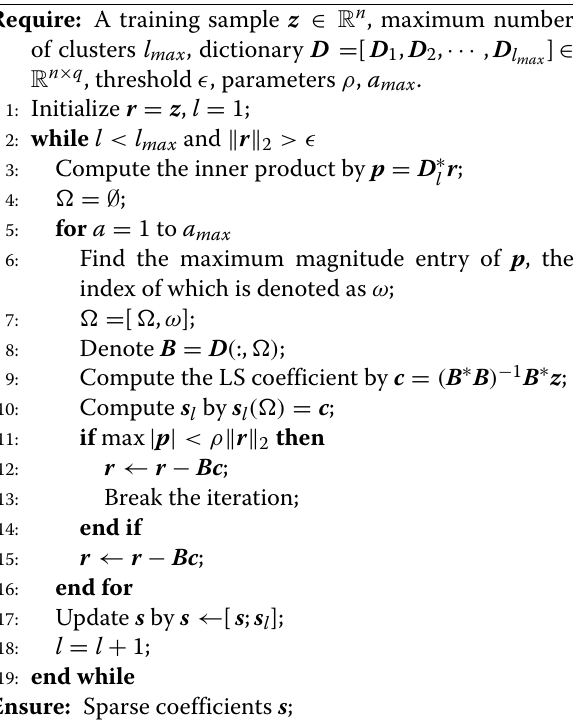
Algorithm 3 Sparse recovery for